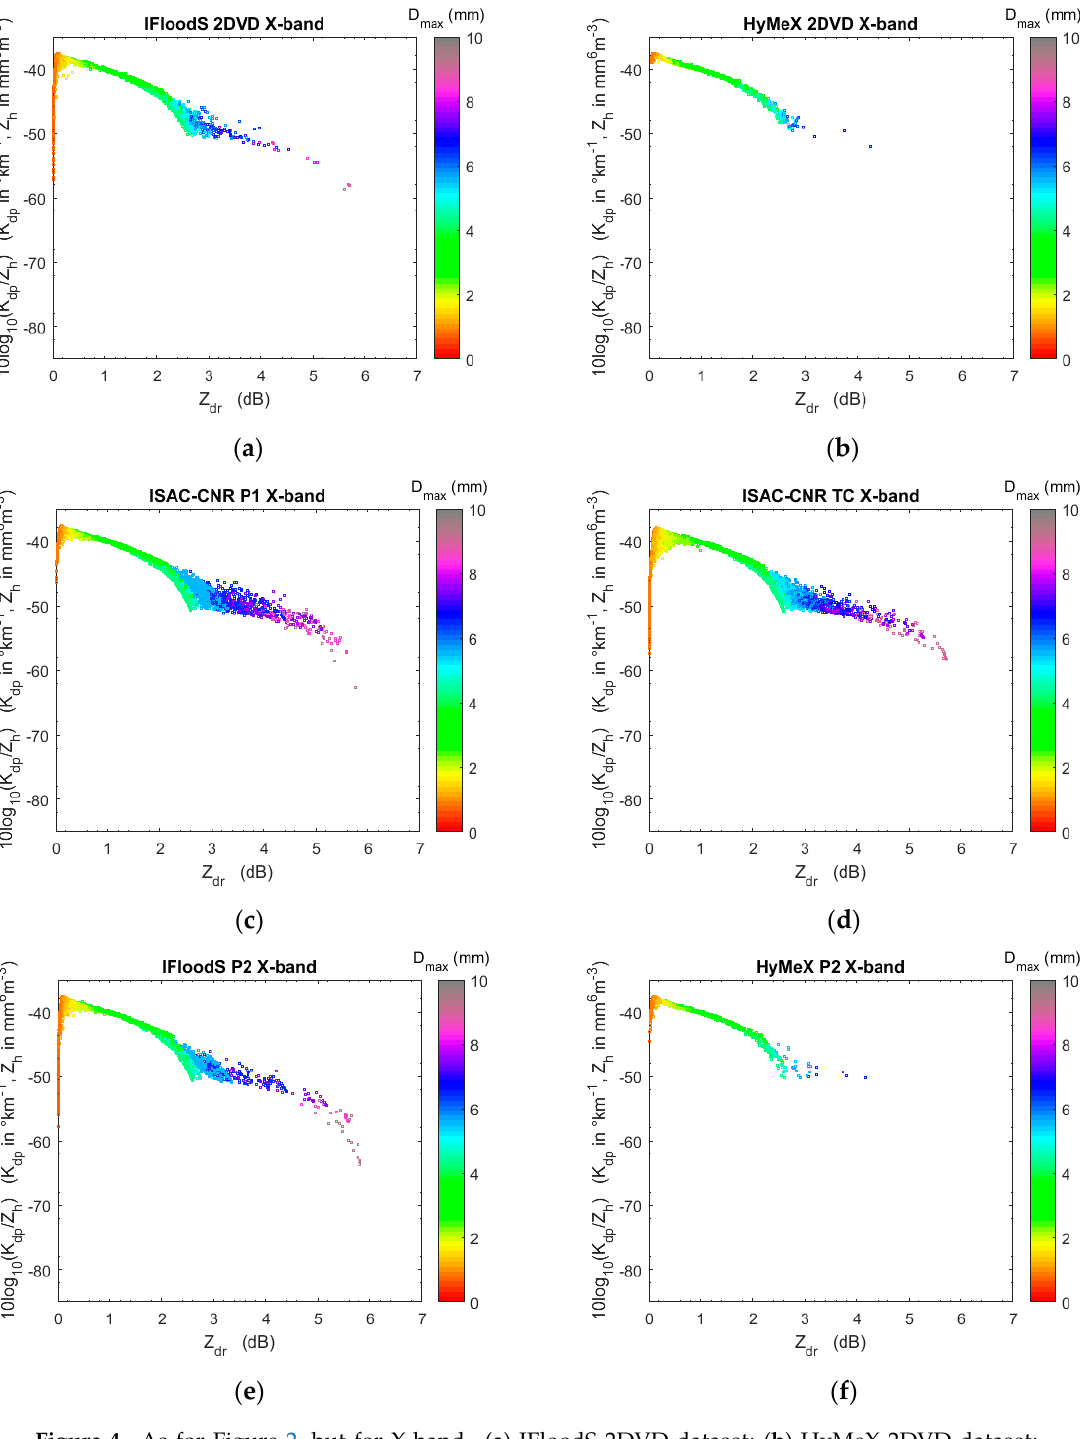
Figure 4. As for Figure 2, but for X-band. ( a ) IFloodS 2DVD dataset; ( b ) HyMeX 2DVD dataset; ( c )